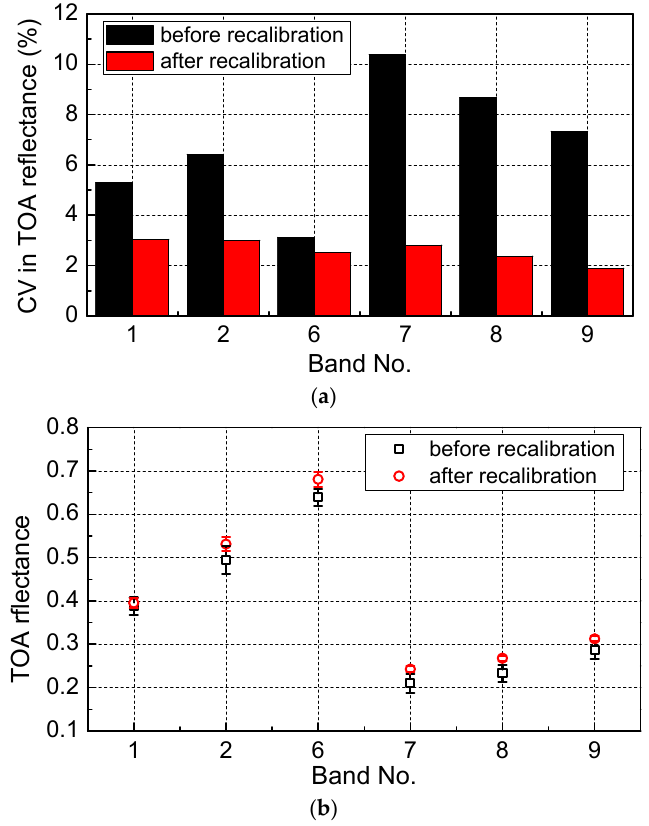
Figure 10. ( a ) Coefficients of variation and ( b ) averaged value in the TOA reflectance among the three VIRR sensors onboard FY-3A, FY-3B, and FY-3C from January 2009 to December 2017 before and after consistent calibration.